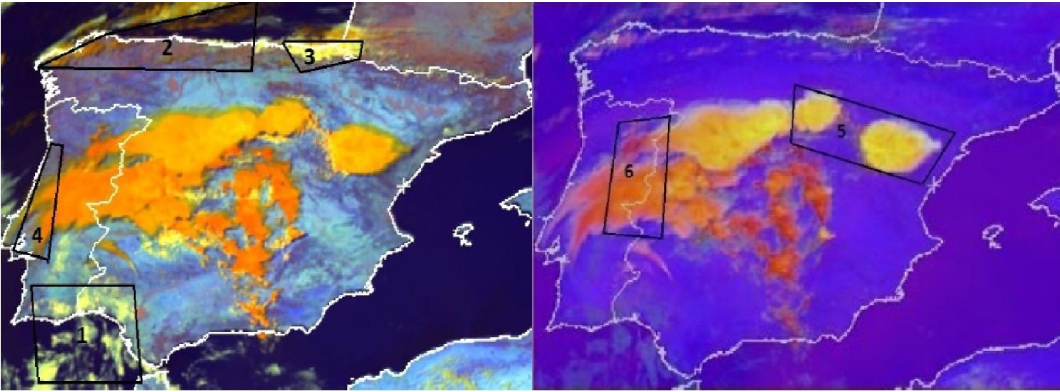
Fig. 2. 14:00UTC on 12 August 2011. Left, RGB image “day solar”; right, RGB image “convective storm”. Different cloud types are marked. 1: stratus; 2: cirrus; 3: nimbostratus; 4: cirrostratus; 5: developing convection; 6: dissipating